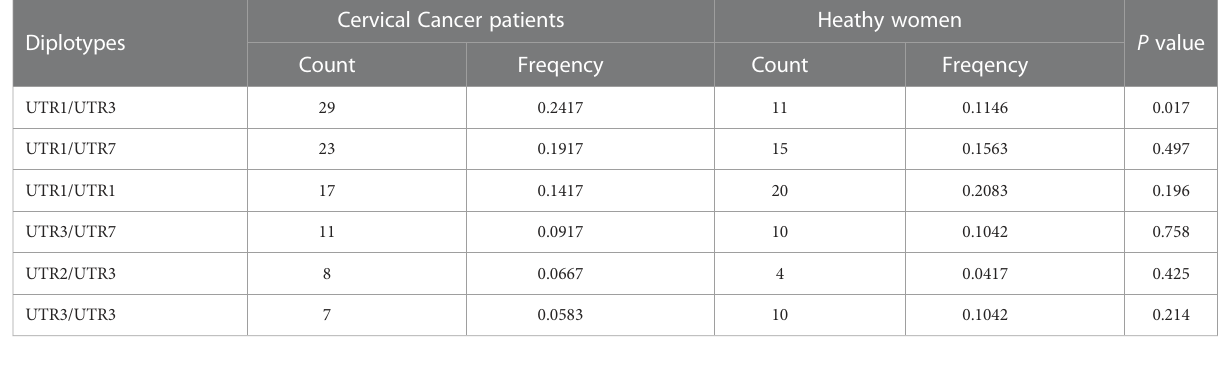
TABLE 4 HLA-G 3 ’ UTR diplotype frequencies among patients and controls. Cervical Cancer patients Diplotypes